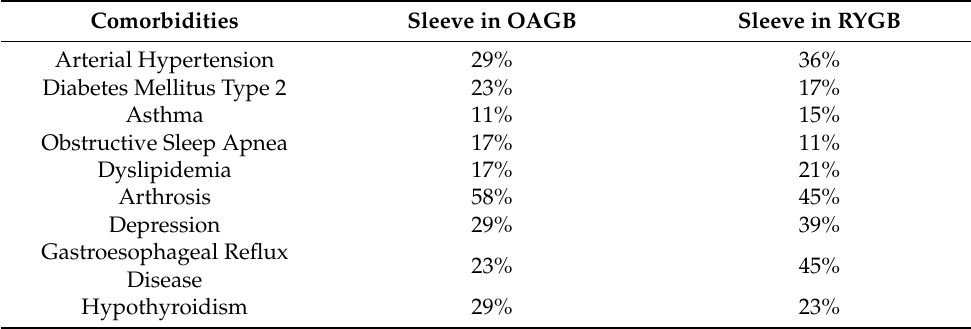
Table 3. Comparison of Delta BMI, %WL and %EWL before and after One Anastomosis Gastric Bypass.